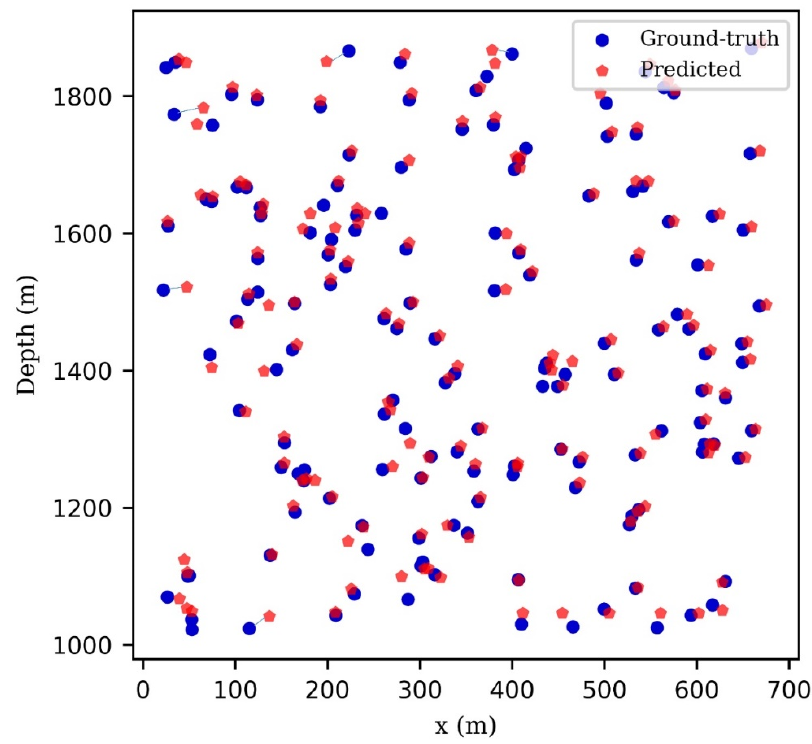
Figure 12. The 2-D section view project of the predicted versus ground-truth microseismic events. Blue dots represent the ground-truth locations while the red pentagons represent the inverted events.